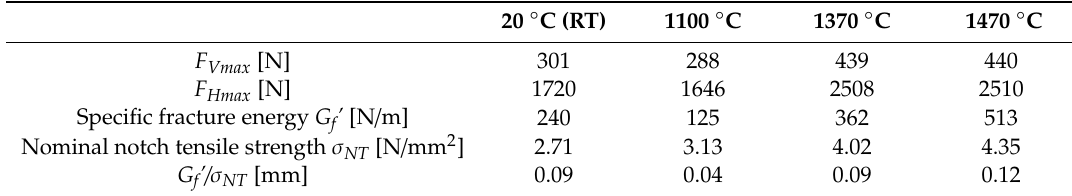
Table 1. Fracture mechanical parameters determined from tests performed at room temperature (RT), 1100 ◦ C, 1370 ◦ C, and 1470 ◦ C.